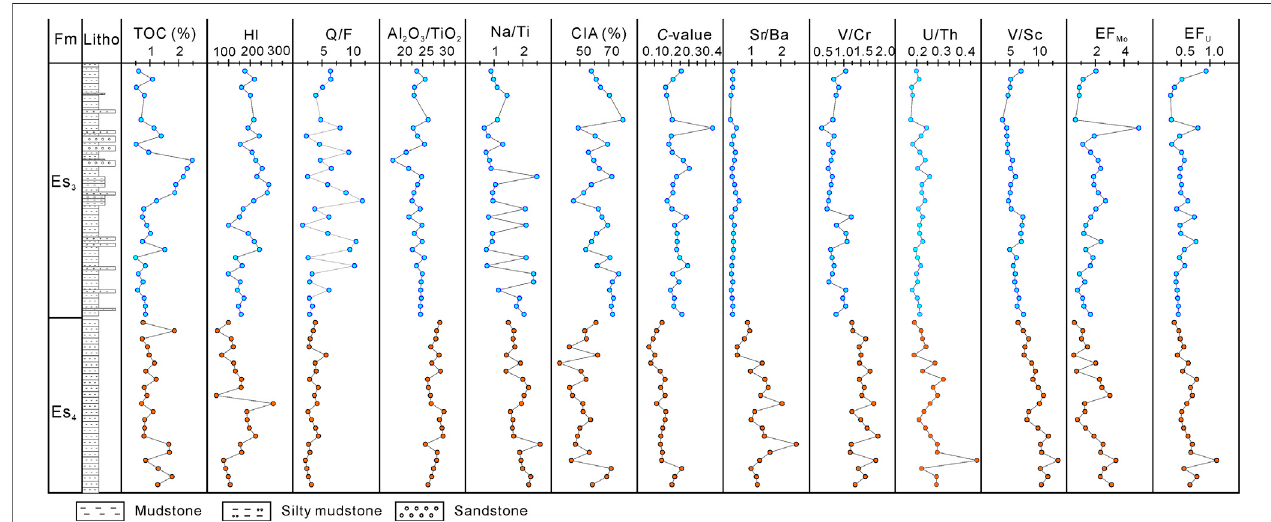
FIGURE6| Geochemicalproxiesofpaleoclimate(chemicalweathering),salinity,palaeoproductivity,andredoxconditionsintheEs 3 andEs 4 samplesintheLanggu sag, Jizhong subbasin. Fm, Formation. Litho, Lithology.